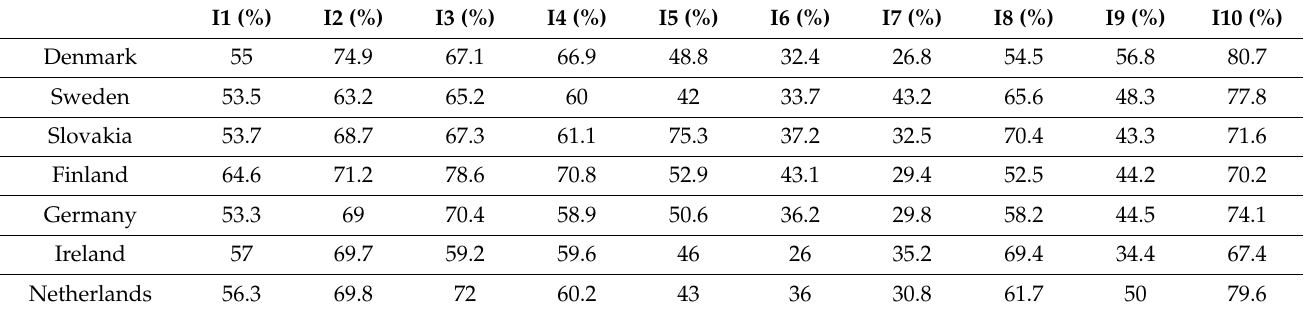
Table 2. Percentages of telework adoption associated with the study